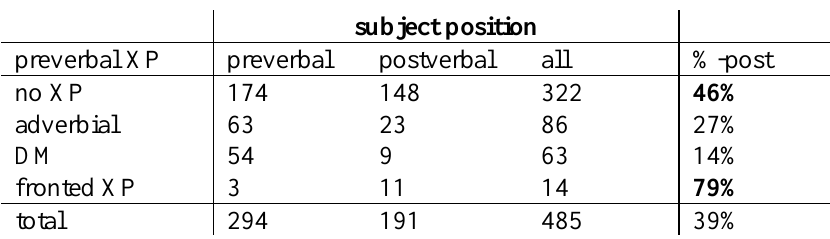
Table 2. Subject-verb inversion according to the presence of a preverbal XP subject